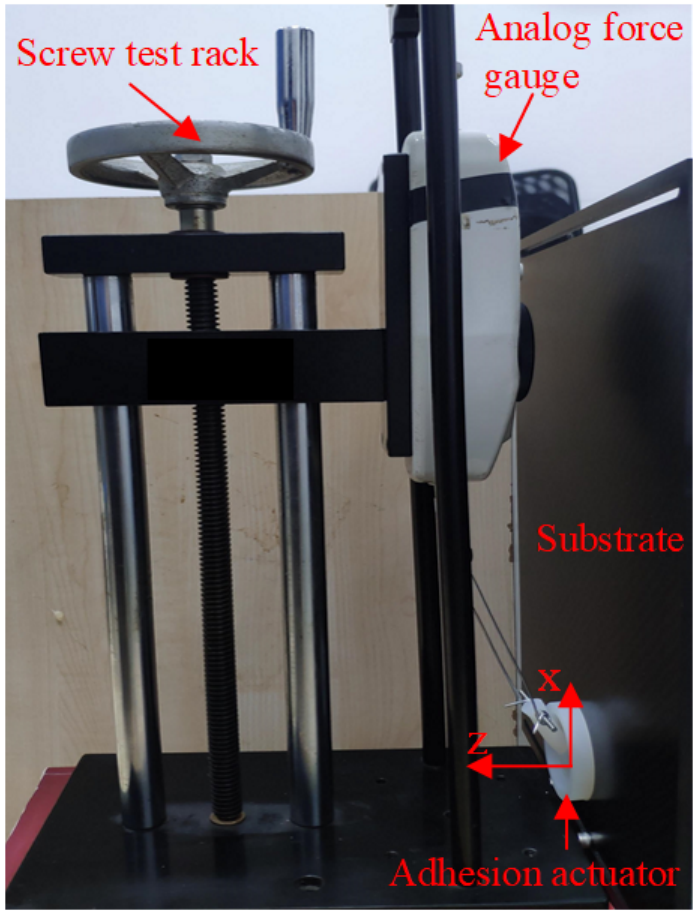
Figure 5. Experimental testing of maximum shear adhesion